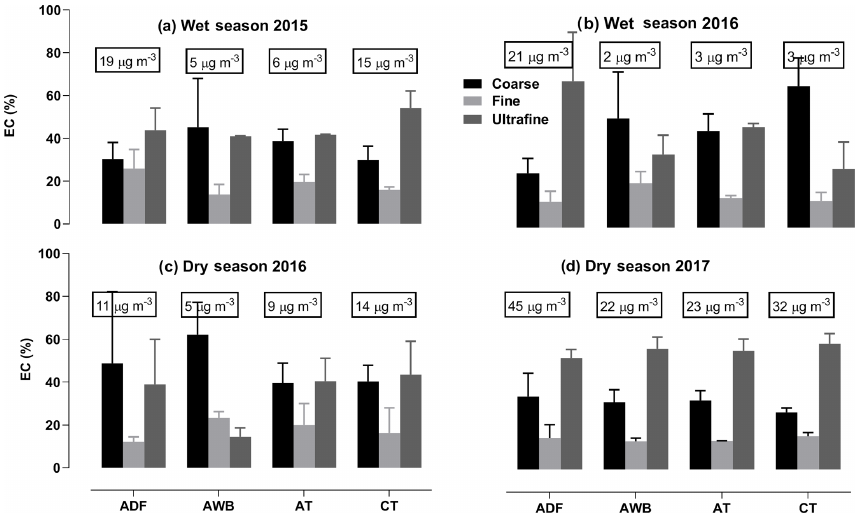
Figure 8. EC relative concentrations in each size classes (C in black, fine in light grey, ultrafine in grey) at the different study sites for each campaign. Bulk EC concentration for each site is indicated in boxes.